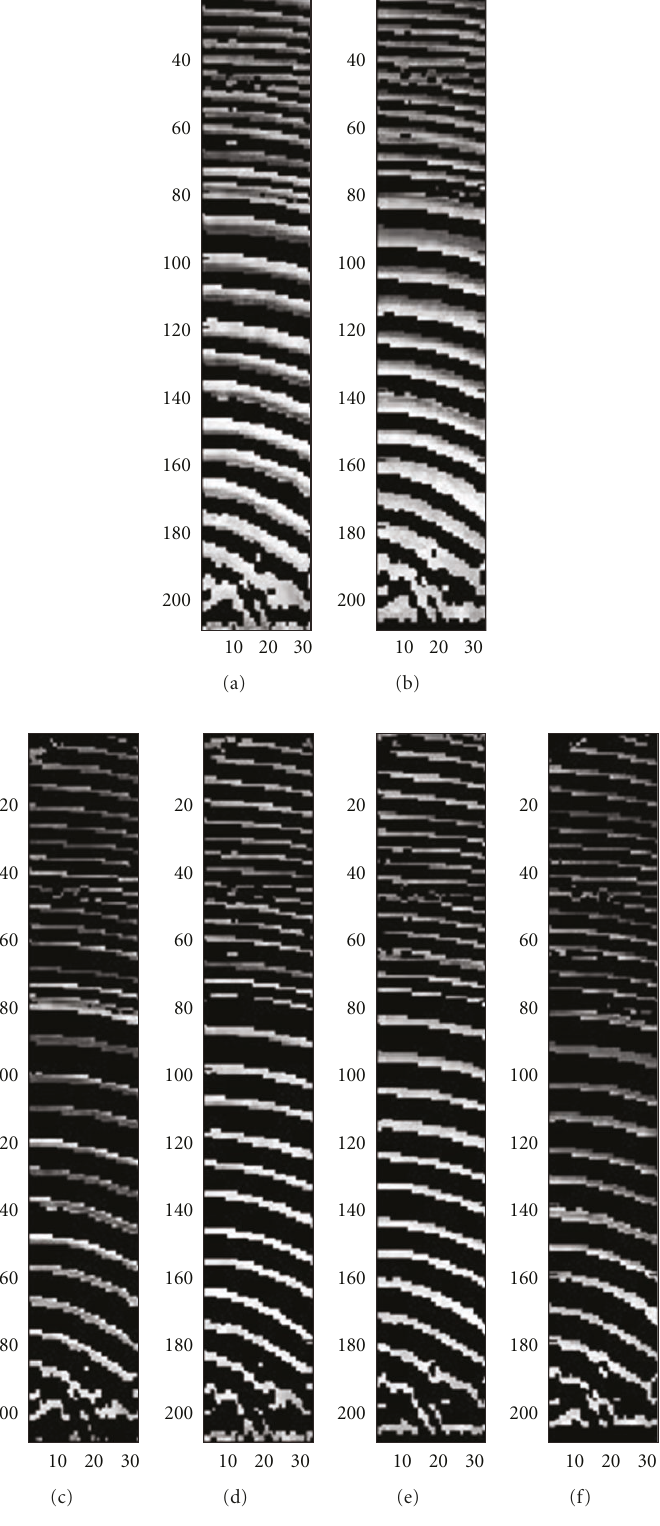
Figure 20: Tree growth estimates for spruce sample using variable frequency spacing filterbank (sample 10 from Grissino-Mayer database). (a) First-half season, (b) second-half season. Quarterly growth estimates: (c) 1st, (d) 2nd, (e) 3rd, and (f) 4th